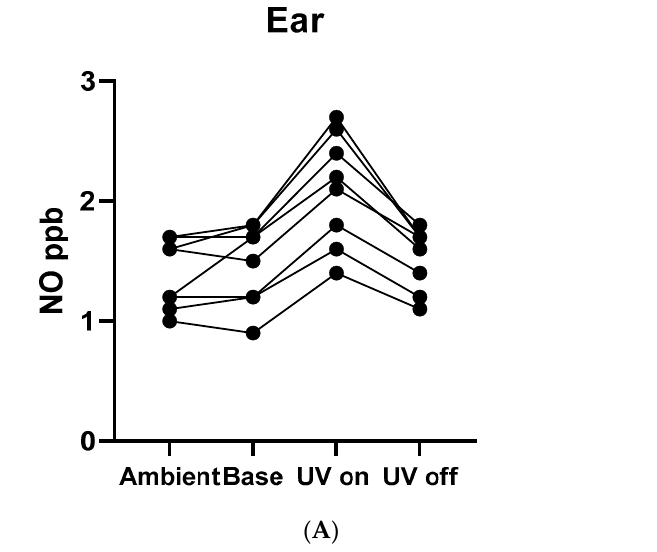
Figure 4. The NO signal was recorded by EcoPhysics NOA in the human study. An ambient air (ambient), NO from the ear ( A ) or forearm ( B ) at baseline with the light off (Base) and the same area during the UV probe exposure (UV), followed by UV light off (UV off) were recorded.